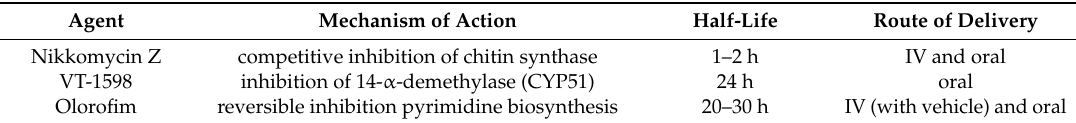
Table 2. Antifungals on the